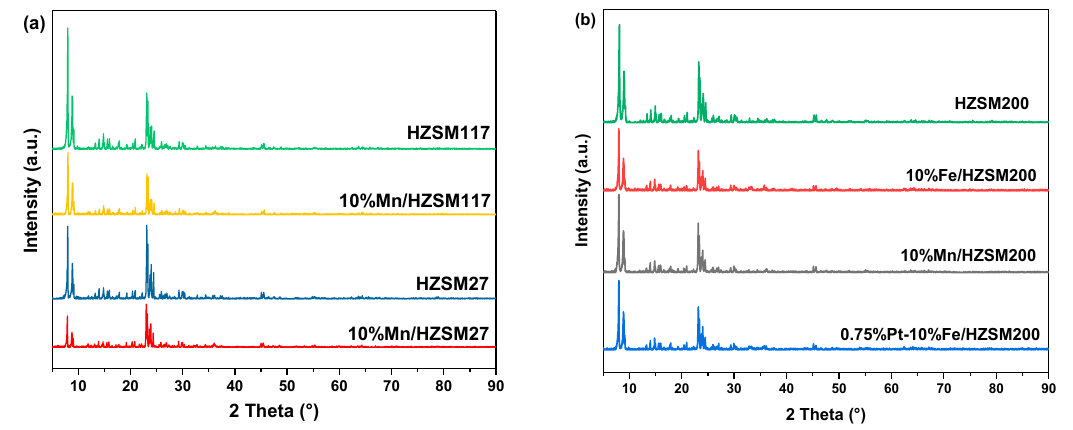
Figure 3. XRD patterns of the catalysts ( a ) HZSM supports and their supported Mn catalysts; ( b ) HZSM200 and its supported catalysts.